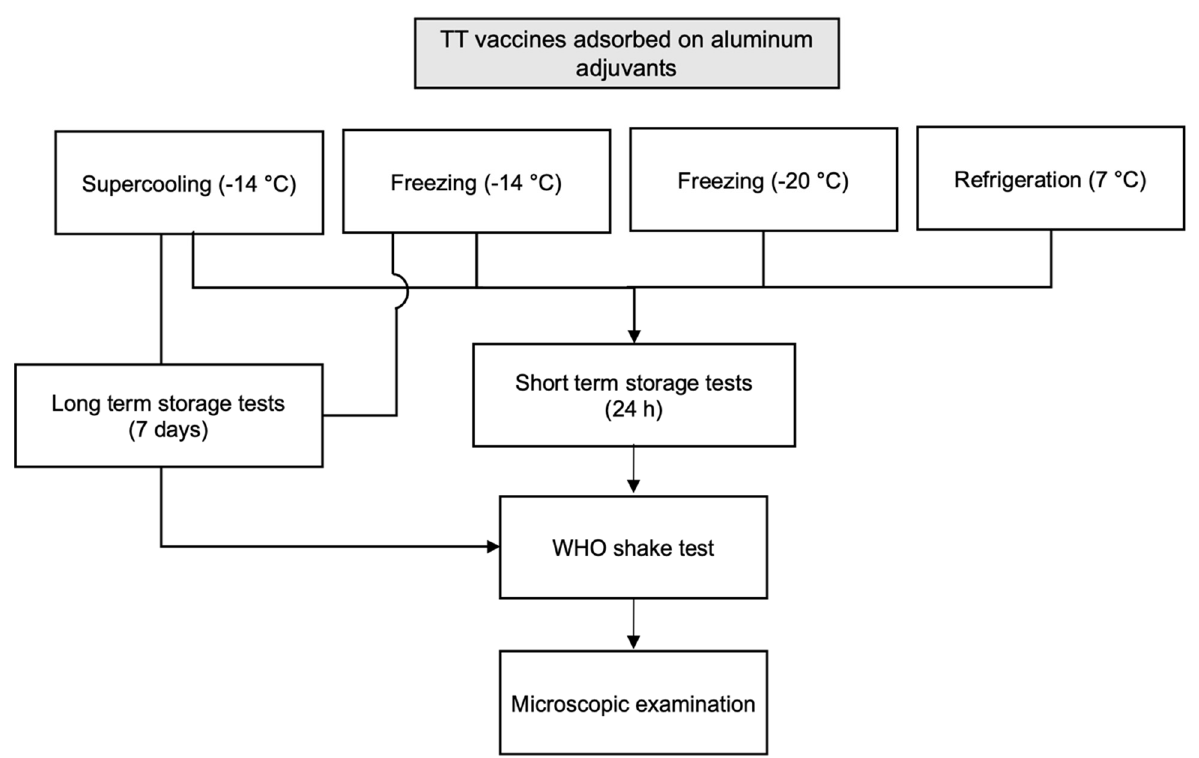
Figure 2. A flow chart of the experimental design to validate the supercooling preservation of vac- cines.